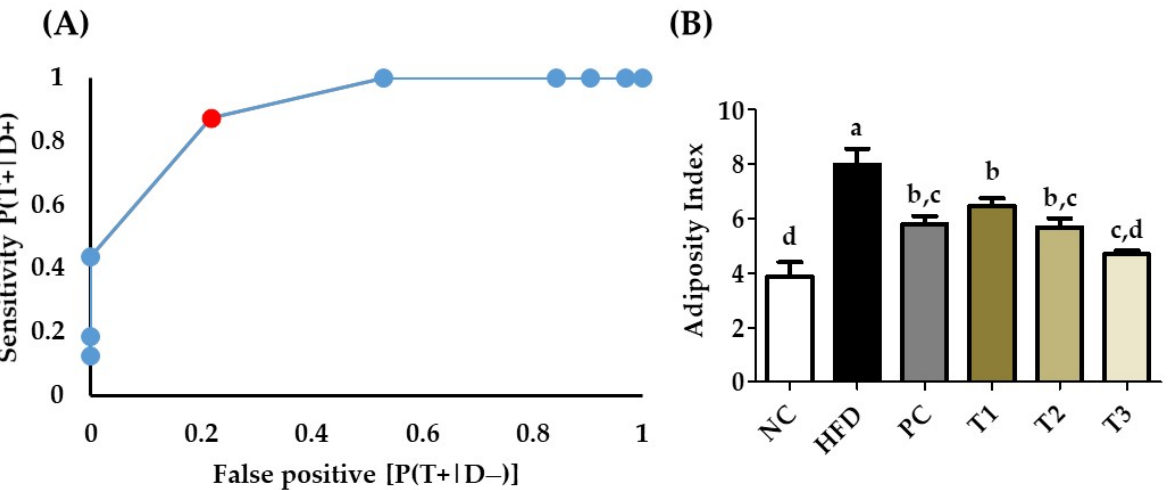
Figure 12. ( A ) Receiver operating characteristic (ROC) curve of body weight index (Red dot represent the cut off value) and area under the curve (ROAUC) and ( B ) adiposity index. Values with different letters present significant differences ( p < 0.05).